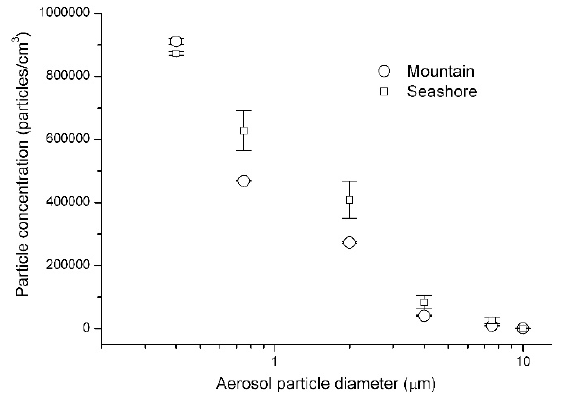
Figure 4. Concentrations of aerosol particles: mountain site (circle) and seashore site (square). Table 3. Concentrations of aerosol particles and culturable bioaerosols (d p = particle diameter). Particles